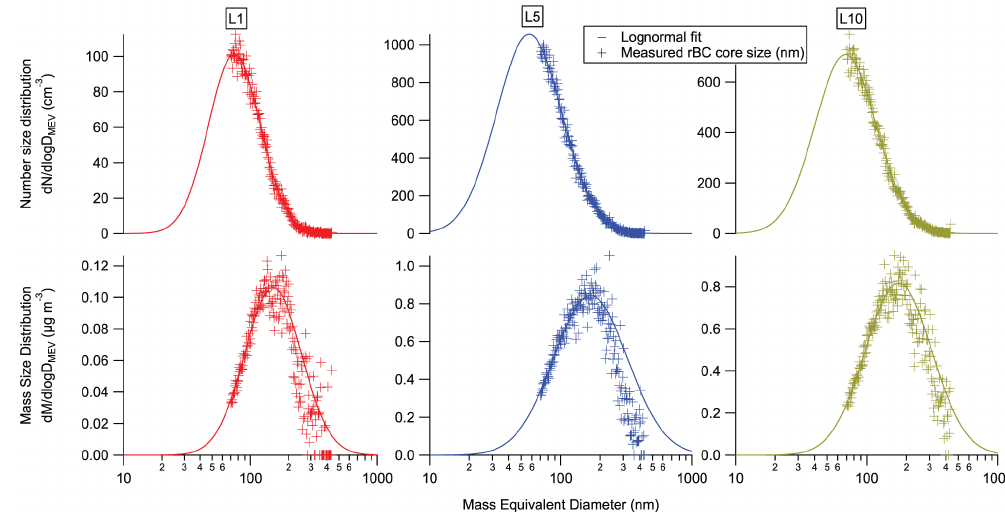
Figure 11. rBC core size distributions and corresponding lognormal fits for LEO periods L1, L5, and L10.